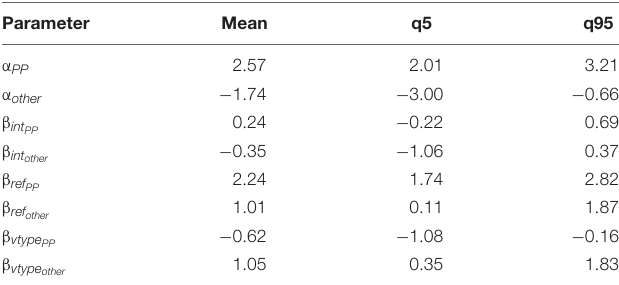
TABLE 3 | Mean estimate and credible interval for the parameters of the Mirror model, Experiment 1.